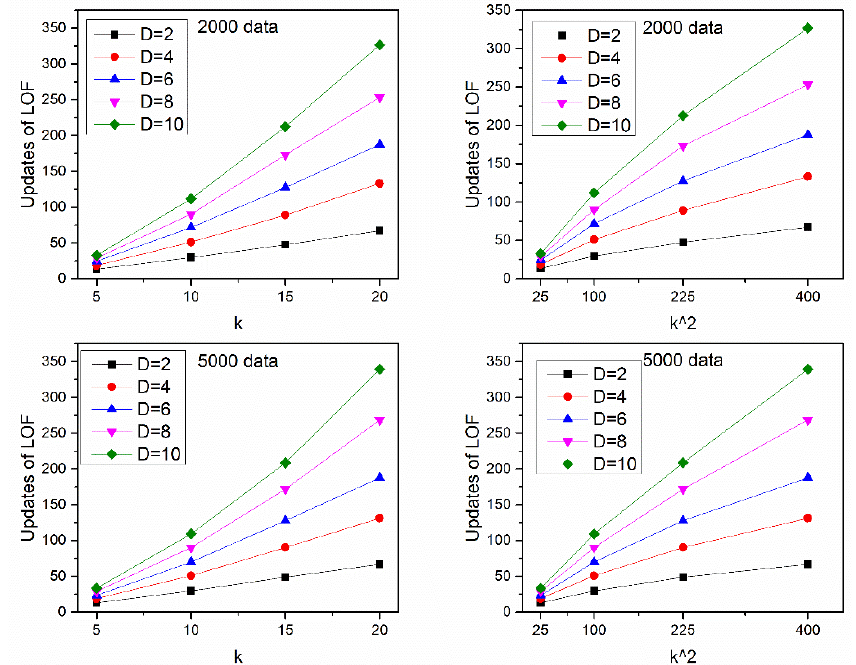
Figure 5. The dependence of the number of CLOF updates on data dimension D and parameter k using data simulated from a standard Gaussian distribution.